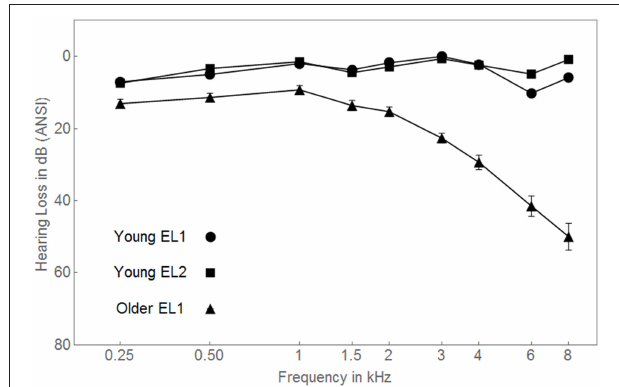
FIGURE 2 | Average audiograms for the three groups of participants are shown for the left ear. ANSI, American National Standards Institute. Standard error bars are shown.